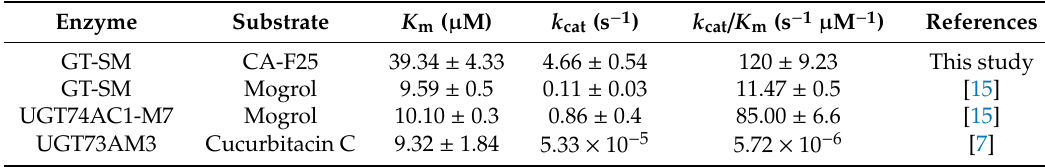
Table 1. Kinetic parameter of GT-SM toward cucurbitacin F